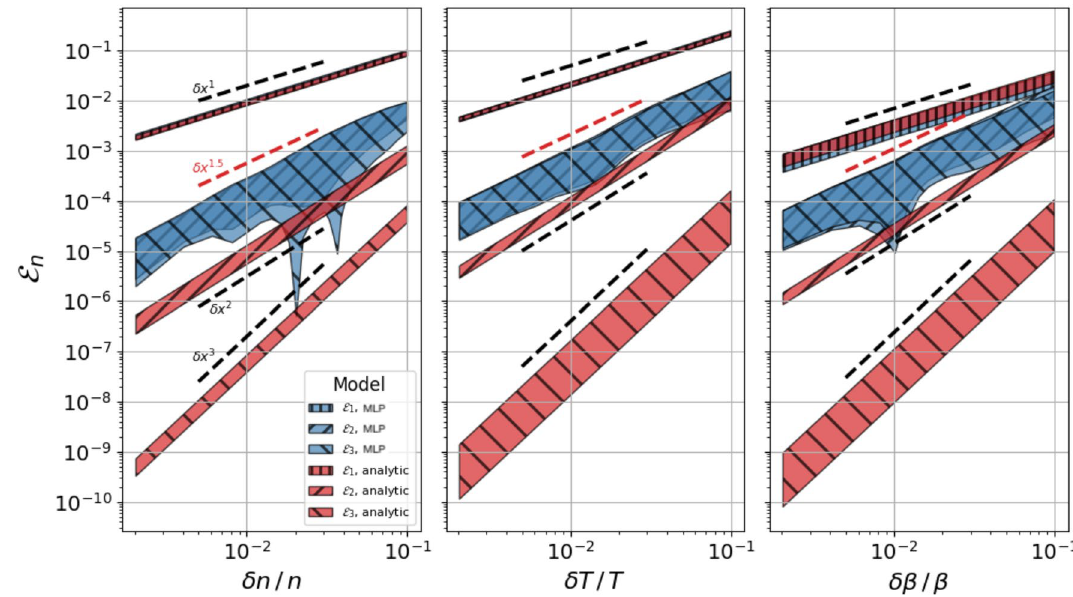
Figure 1. Taylor expansion’s error: residual error from Taylor expansion up to order 0, 1, 2 (corresponding 1, 2, 3 , respectively in the legend) of the analytic flux function q in Eq. (13) (red) and its MLP to E p with p = representation (blue). Each panel corresponds to variations of each individual thermodynamic variable, with the shaded regions representing the range between the absolute of the mean value (bottom boundary) and one standard deviation (upper boundary) for a sample of 30 randomly chosen expansion